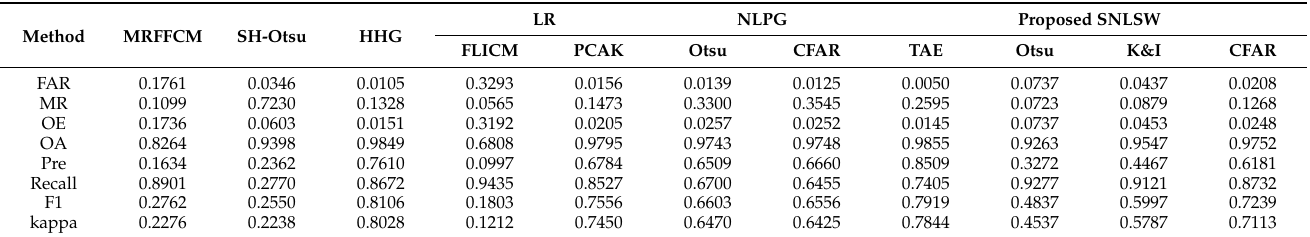
Table 4. Quantitative evaluation of the different methods on Dataset #4.